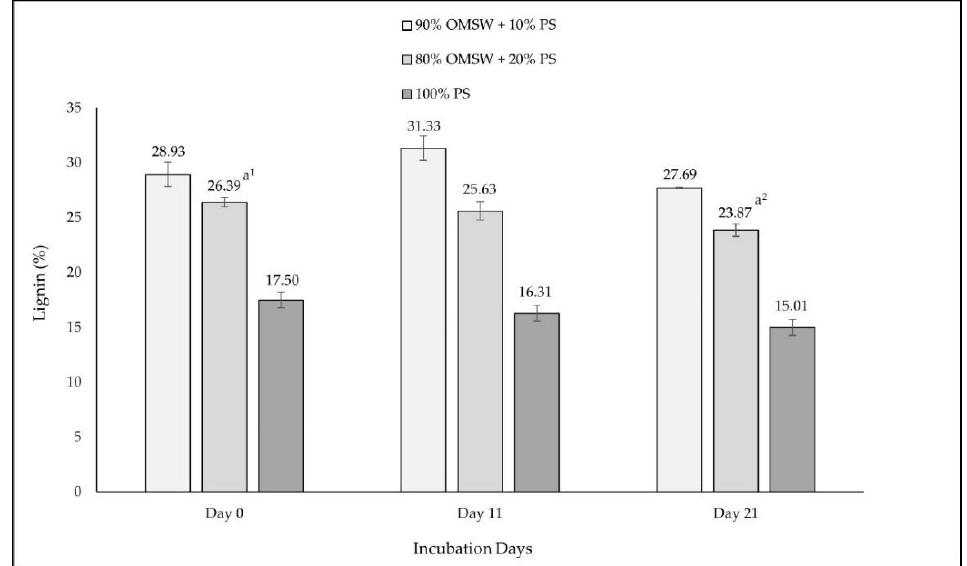
Figure 8. Assessment of Lignin content for PS and its mixtures with OMSW. Statistical analysis was performed for each substrate individually between Day 0 and Day 21. Different superscripts between the same letters indicate statistical significance ( p ≤ 0.05).